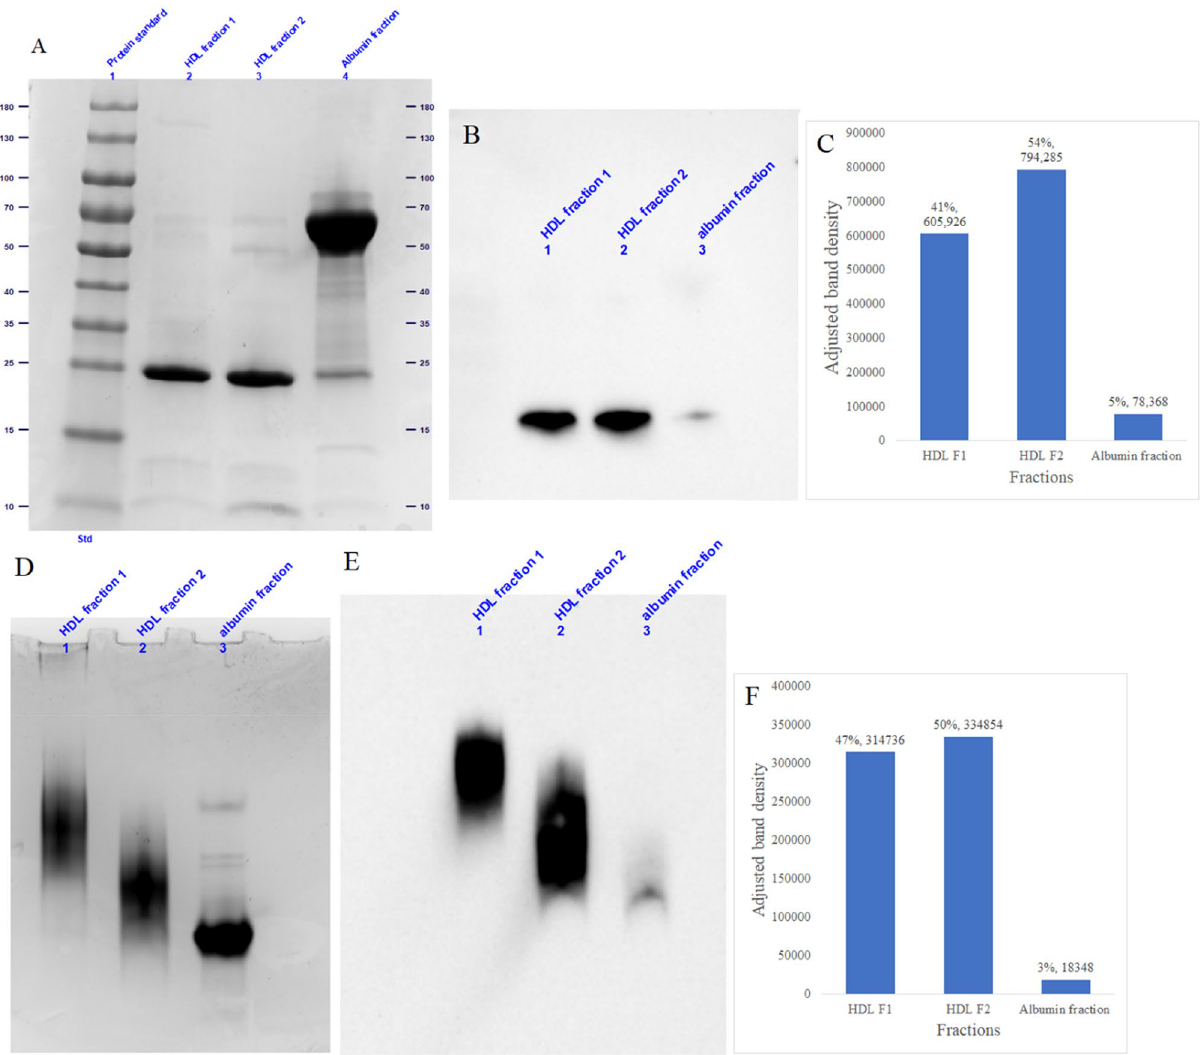
Figure 4. Sodium dodecyl sulfate (SDS)- and native- polyacrylamide gel electrophoresis (PAGE) and Western blot analysis on HDL fraction 1, HDL fraction 2, and albumin fraction. ( A ) SDS-PAGE stained with coomassie blue protein stain. ( B ) Western blot membrane showing ApoA-I proteins transferred from the gel shown in ( A ). ( C ) The relative and absolute value of band density of each ApoA-I band in the Western blot shown in ( B ). ( D ) Native-PAGE stained with coomassie blue protein stain. ( E ) Western blot membrane showing ApoA-I proteins transferred from the gel shown in ( D ). ( F ) The relative and absolute value of band density of each ApoA-I band in the Western blot shown in ( E